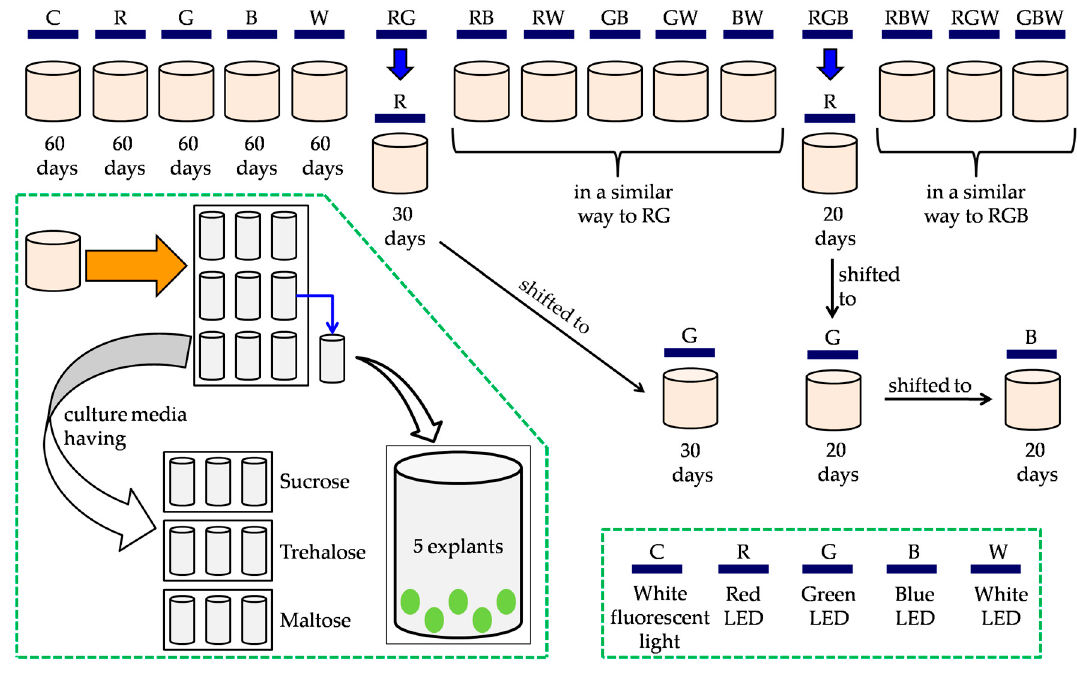
Scheme 1. Visualization of the experimental layout. C, control.